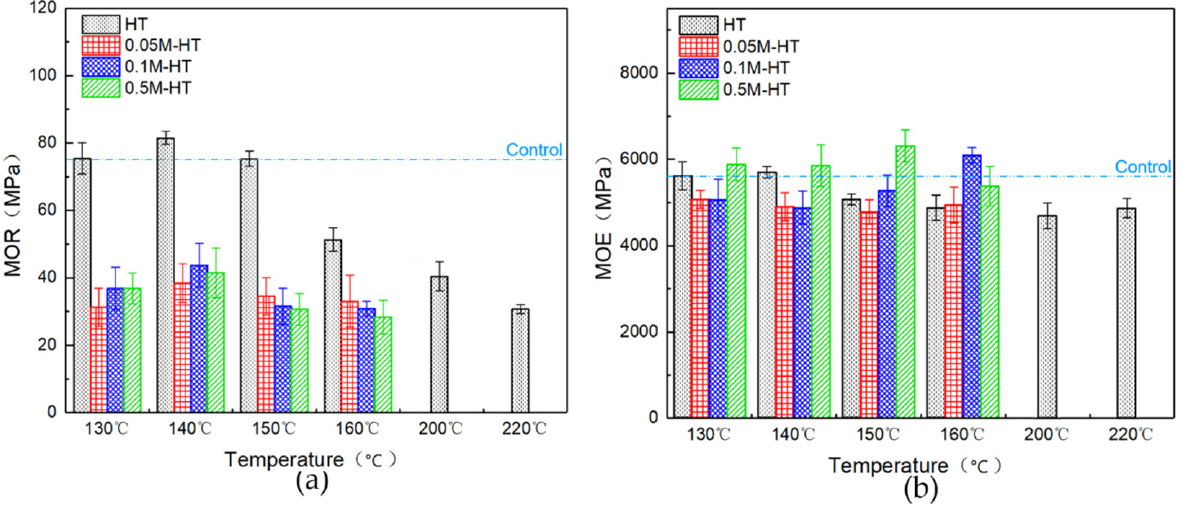
Figure 4. ( a ) MOR and ( b ) MOE of samples for different treatment